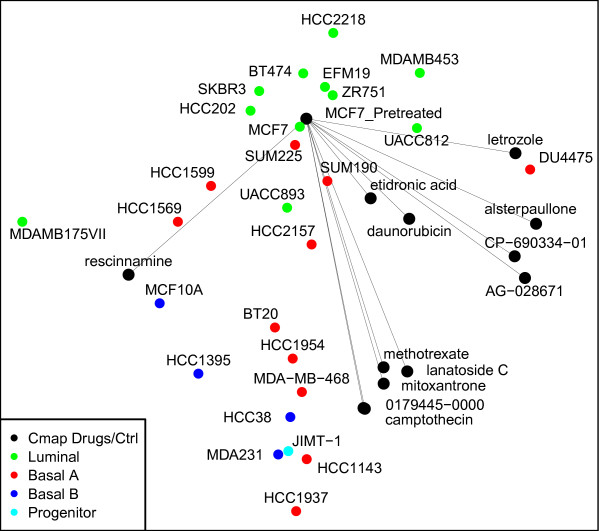
3A drug transitions. NeRV visualization showing Drug Treatment Transitions. Lines indicate the transition from Pretreated MCF7 to treated MCF7 cells.